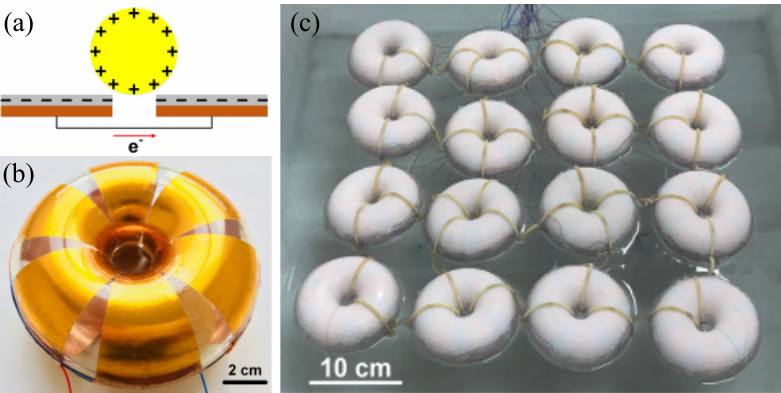
Figure 17. A triboelectric nanogenerator as a power take-off mechanism with its work principle ( a ), a torus-shaped PA prototype ( b ) and an array ( c ), adapted from